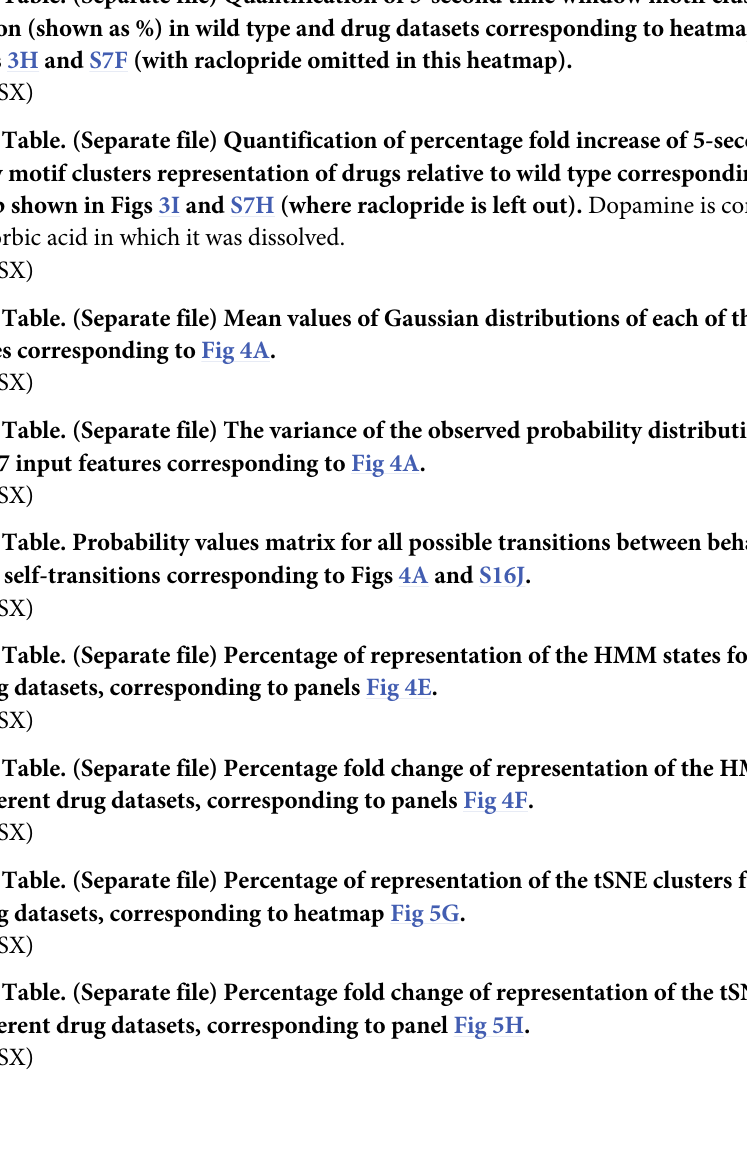
S15 Table. (Separate file) Mann–Whitney U 1-sided (greater) tests with Bonferroni correc- tion for statistical significance analysis of the data shown in S3–S6 Figs. (XLSX) S16 Table. (Separate file) Quantification of 1-second time window motif clusters represen- tation (shown as %) in wild type and drug datasets corresponding to heatmaps shown in Figs 3F and S7E (in this case, raclopride is not included in the heatmap). (XLSX) S17 Table. (Separate file) Quantification of percentage fold increase of 1-second time win- dow motif clusters representation of drugs relative to wild type corresponding to heatmap shown in Figs 3G and S7G (raclopride is omitted in this heatmap). Dopamine is compared to ascorbic acid in which it was dissolved. (XLSX) S18 Table. (Separate file) Quantification of 5-second time window motif clusters represen- tation (shown as %) in wild type and drug datasets corresponding to heatmap shown in Figs 3H and S7F (with raclopride omitted in this heatmap). (XLSX) S19 Table. (Separate file) Quantification of percentage fold increase of 5-second time win- dow motif clusters representation of drugs relative to wild type corresponding to the heat- map shown in Figs 3I and S7H (where raclopride is left out). Dopamine is compared to ascorbic acid in which it was dissolved. (XLSX) S20 Table. (Separate file) Mean values of Gaussian distributions of each of the 7 input fea- tures corresponding to Fig 4A. (XLSX) S21 Table. (Separate file) The variance of the observed probability distributions of each of the 7 input features corresponding to Fig 4A. (XLSX) S22 Table. Probability values matrix for all possible transitions between behavioral states and self-transitions corresponding to Figs 4A and S16J. (XLSX) S23 Table. (Separate file) Percentage of representation of the HMM states for different drug datasets, corresponding to panels Fig 4E. (XLSX) S24 Table. (Separate file) Percentage fold change of representation of the HMM states for different drug datasets, corresponding to panels Fig 4F. (XLSX) S25 Table. (Separate file) Percentage of representation of the tSNE clusters for different drug datasets, corresponding to heatmap Fig 5G. (XLSX) S26 Table. (Separate file) Percentage fold change of representation of the tSNE clusters for different drug datasets, corresponding to panel Fig 5H.